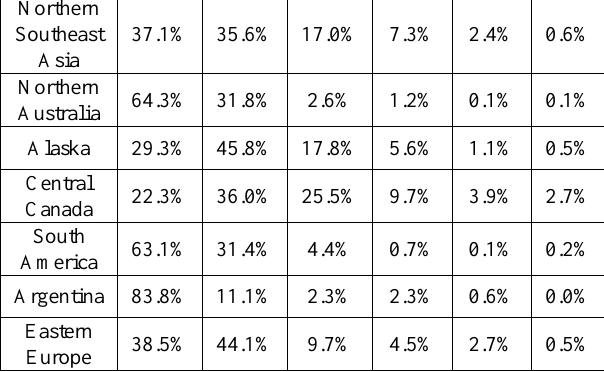
Table 2. Statistical summary of different height of MISR measurements during 2008-2011, over different regions